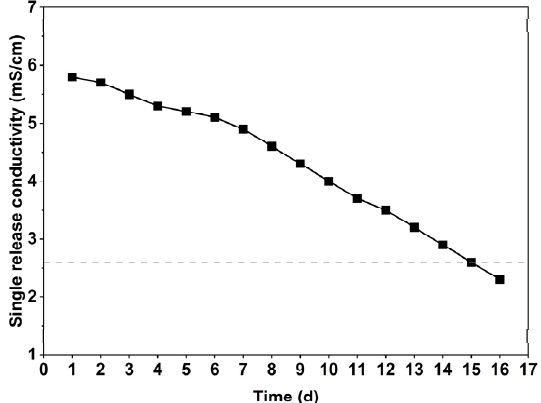
Figure 13. Cyclic soaking conductivity of deicing mixture. Table 5. Durability prediction of deicing agent in different regions.